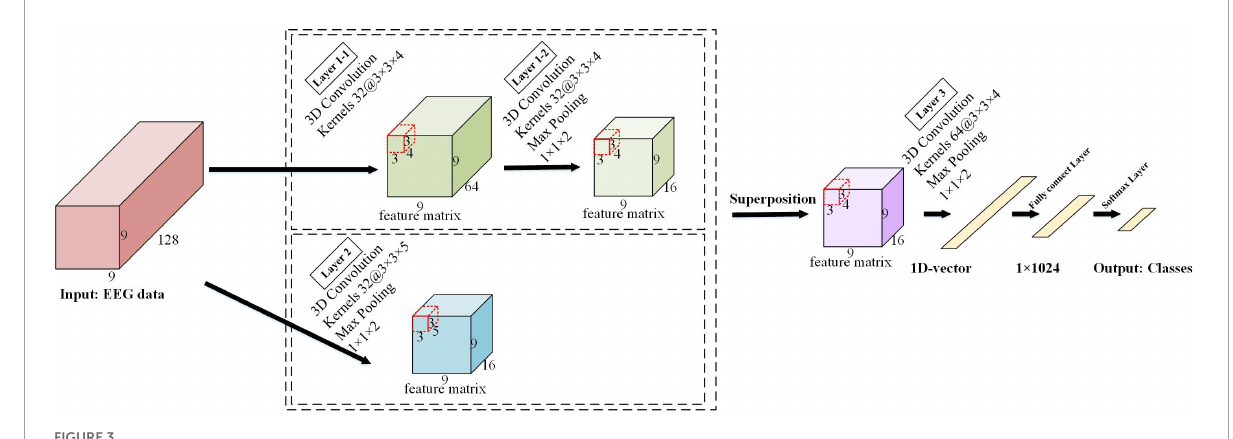
FIGURE3 The framework of the ERN model.